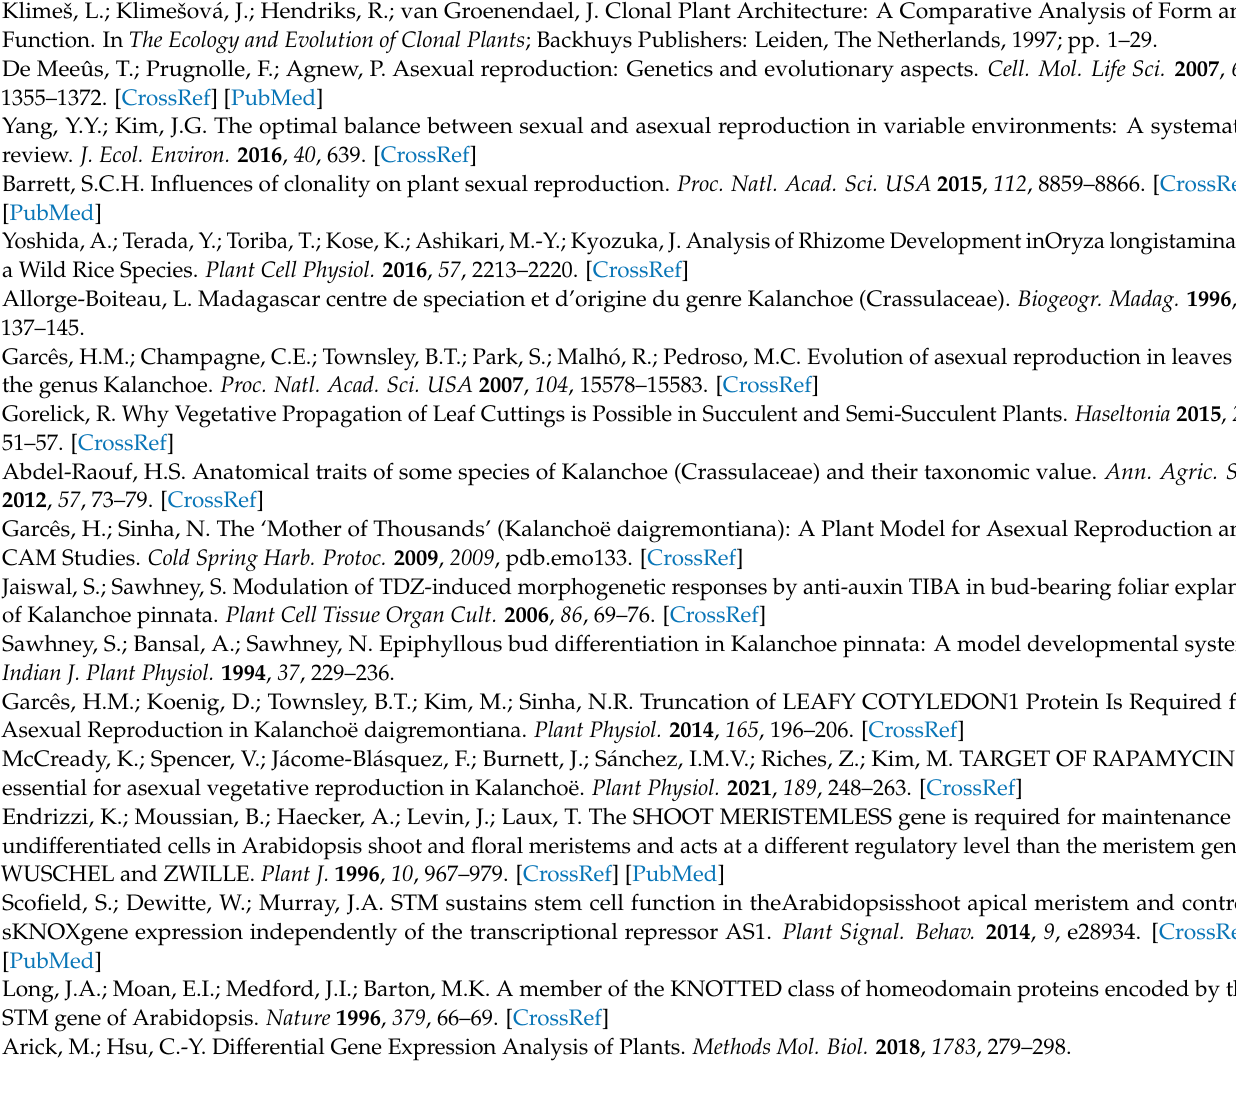
( Kp ). Table S3: List of overrepresented genes in selected GO terms that are shared between two or more gene clusters in K. daigremontiana and K. pinnata . Figure S1. RNA-sequencing reads mapped to the K. fedtschenkoi